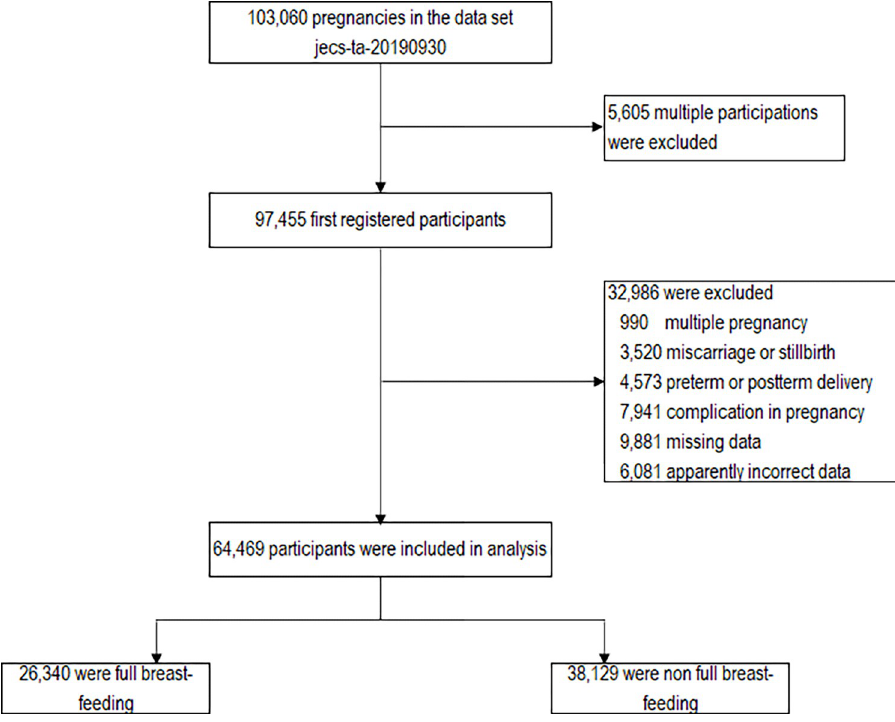
Fig 1. Samples used in statistical